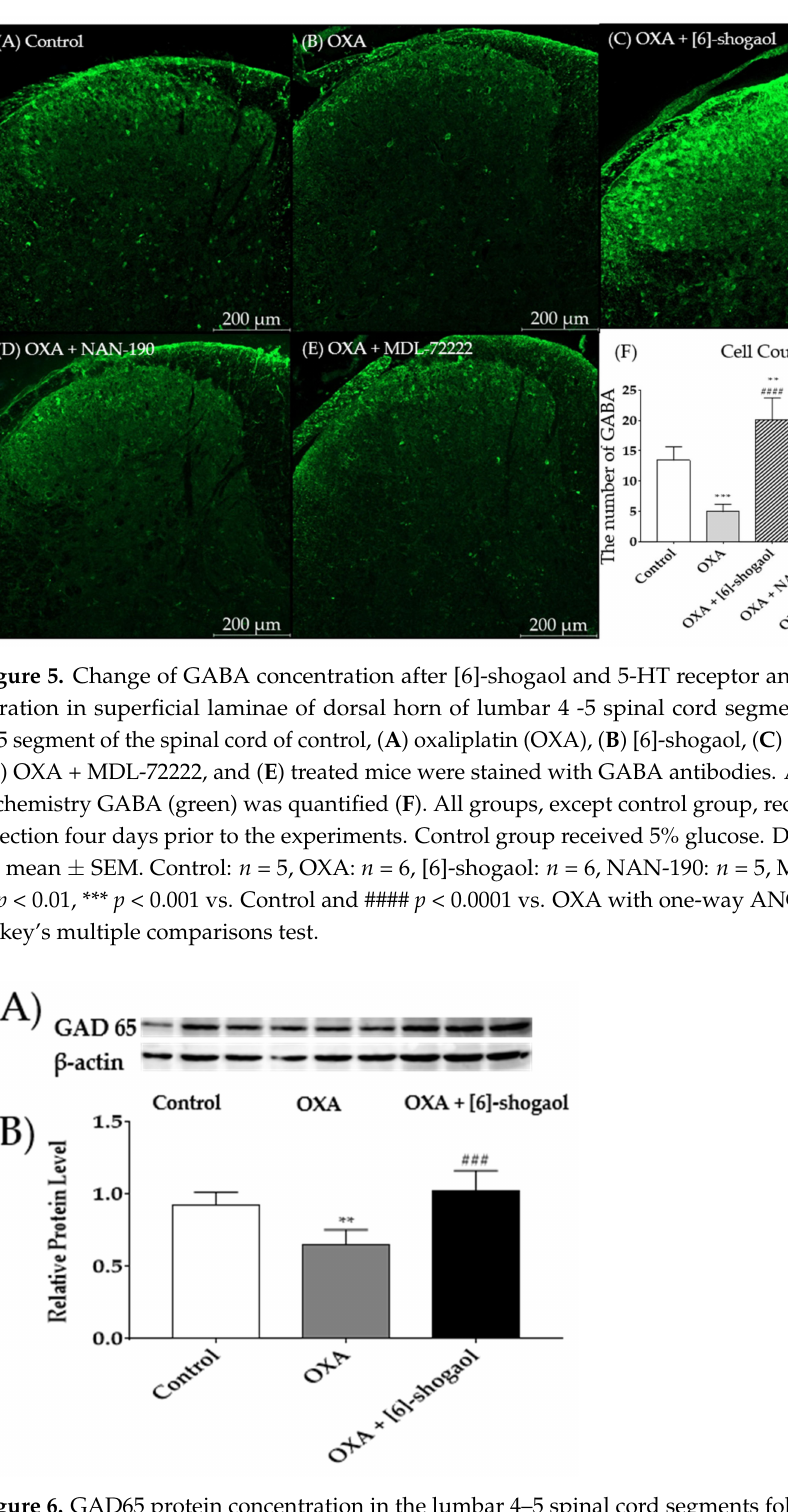
Figure 6. GAD65 protein concentration in the lumbar 4–5 spinal cord segments following intraperi- toneal injection of [6]-shogaol. GAD65 protein binding band density image ( A ). The density of GAD65 protein concentration was quantified compared to β -actin ( B ). Control group received 5% glucose. OXA and OXA + [6]-shogaol groups received oxaliplatin injection four days prior to ex- periments. Data are presented by mean ± SEM. Control: n = 6, OXA: n = 6, OXA + [6]-shogaol: n = 6. ** p < 0.01 vs. Control and ### p < 0.0001 vs. OXA with one-way ANOVA followed by Tukey’s multiple comparisons